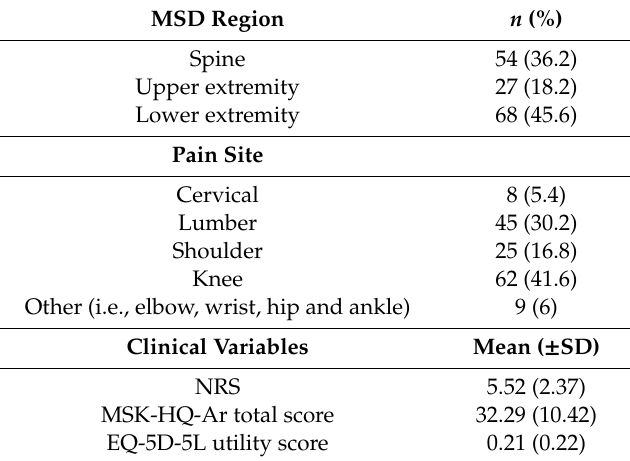
Table 2. Clinical characteristics of the participants ( n =